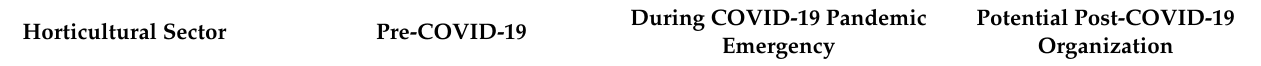
Table 1. Impact of the sanitary emergency on ornamental and vegetable production. Different production sectors were differentially affected and specific potential strategies must be